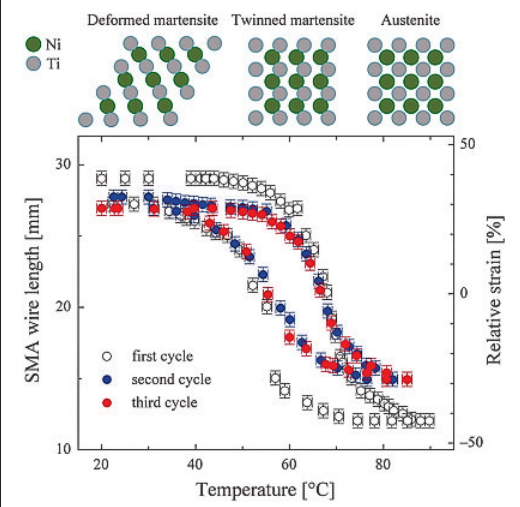
Shape memory alloys exhibit a thermal hysteresis loop as a result of the martensite-austenite lattice phase